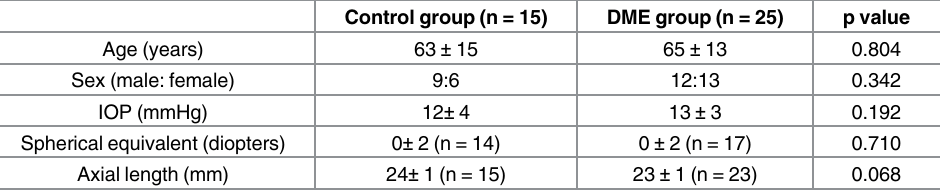
Table 1. Demographics and baseline clinical characteristics of the study participants.